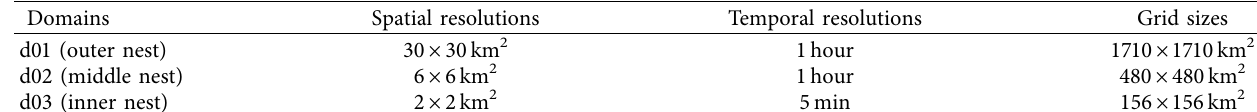
Table 1: WRF domain resolutions.